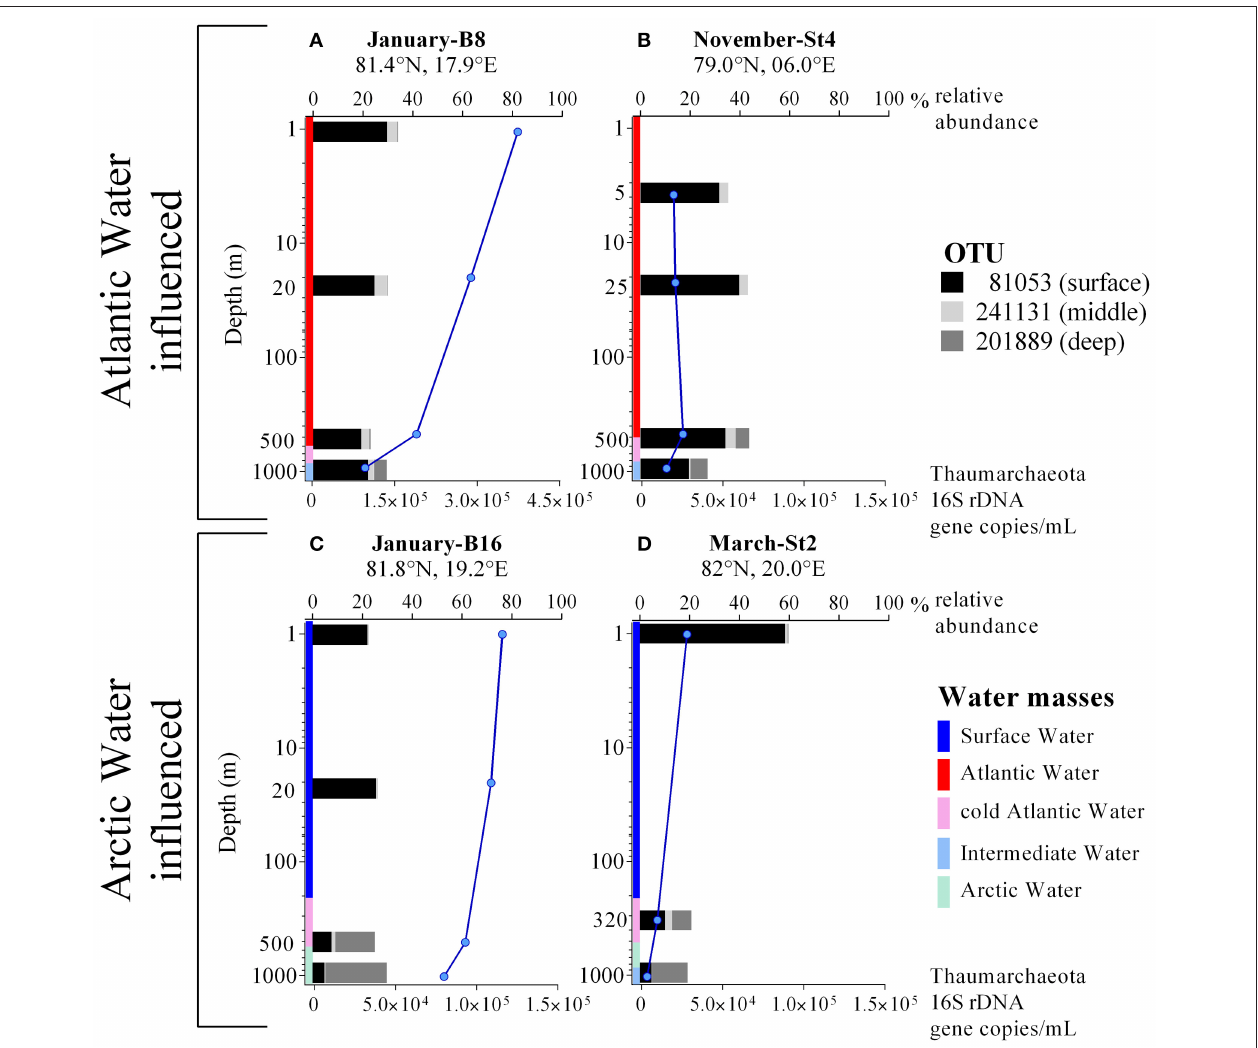
FIGURE 2 | (A–D) Profiles of Thaumarchaeota abundance (blue lines) determined by qPCR of 16S rRNA genes and Thaumarchaeota relative abundance (black, gray, light gray bars; in % of total 16S rRNA Illumina amplicons) from four different stations, where either Atlantic or Arctic water masses were dominating. Notice different scales on the x-axis (lower x-axis for qPCR derived Thaumarchaeota gene copies per mL; upper x-axis for Thaumarchaeota relative abundance from Illumina sequencing data). Colors indicate the water mass profile. Note that the y-axis is in logarithmic